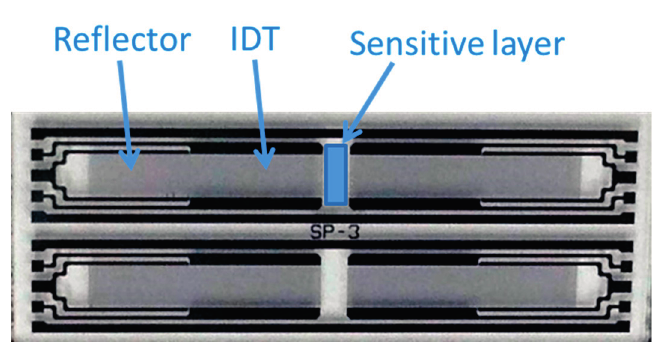
Figure 1. Photograph of a dual-device configuration.